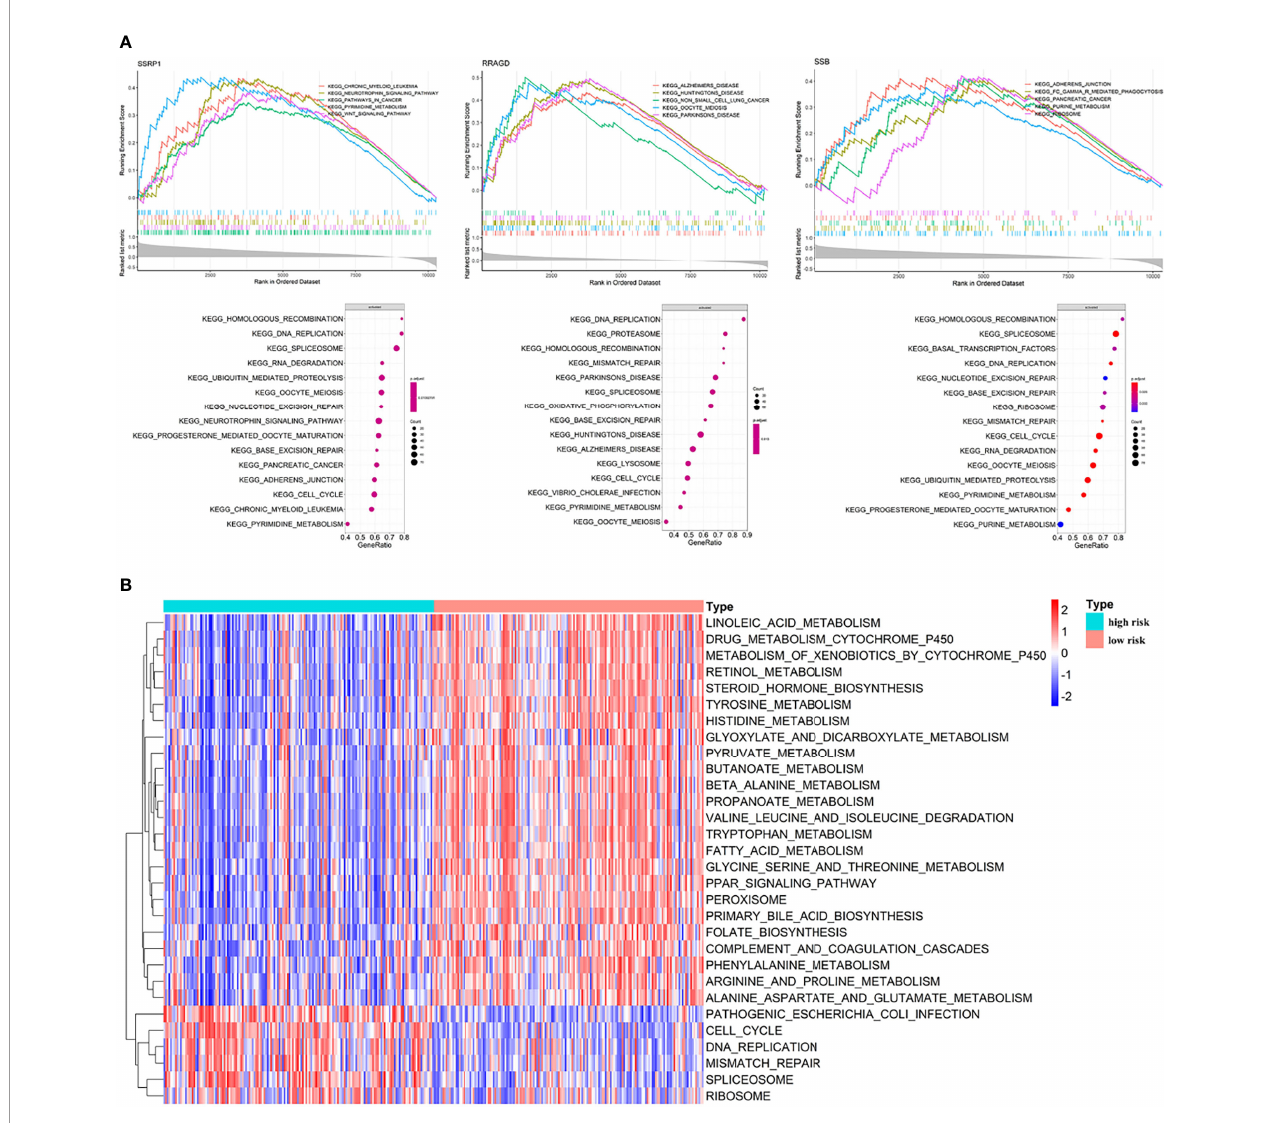
FIGURE 6 | Enrichment analyses. (A) Single gene GSEA results; (B) GSVA results: different pathways between high risk patients and low risk